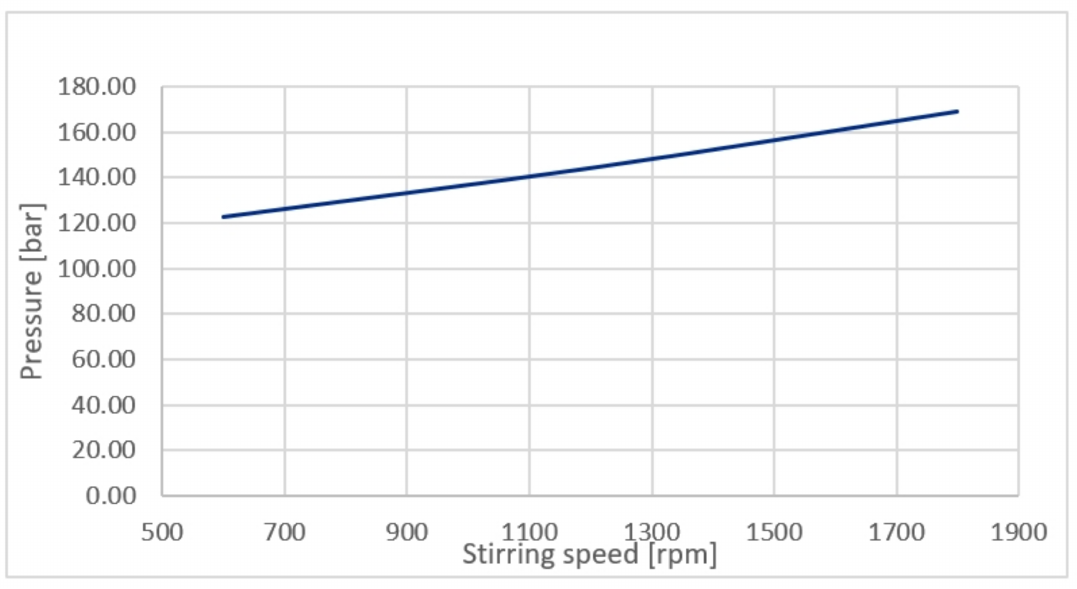
Figure 9. Relationship between operational pressure in an autoclave and stirring speed.